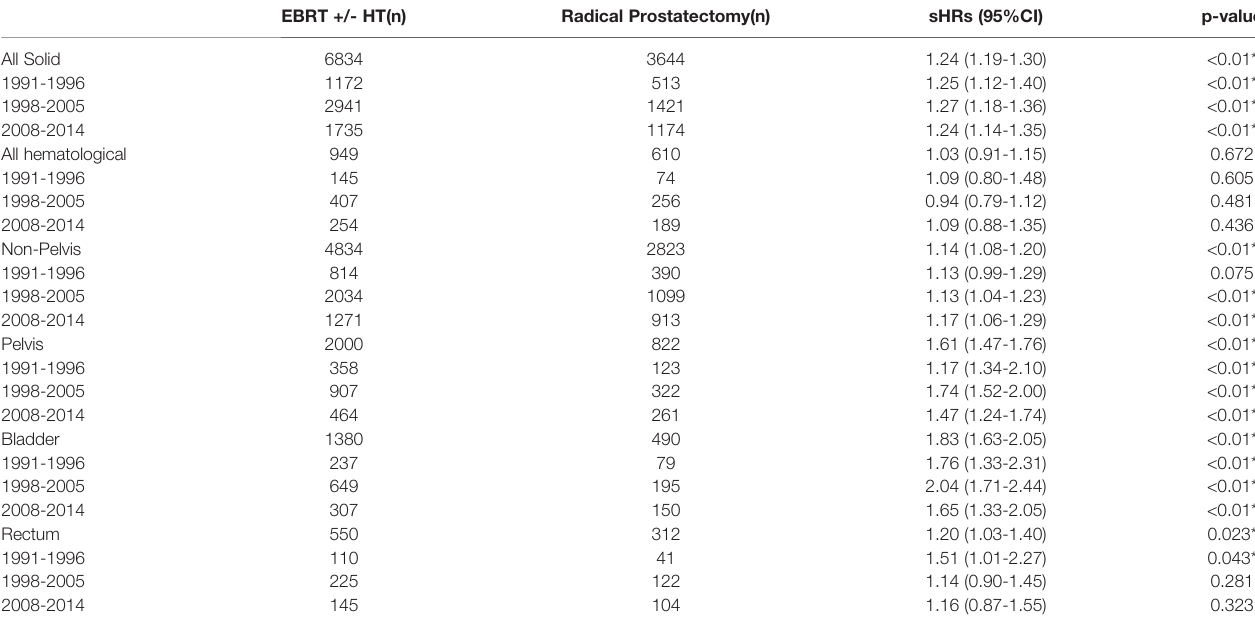
TABLE 3 | Estimated subHazard ratios by gray and fi ne method (with adjustment for age and year of diagnosis) for the EBRT cohort versus the reference cohort prostatectomy. EBRT +/- HT(n) Radical Prostatectomy(n) sHRs (95%CI) p-value All